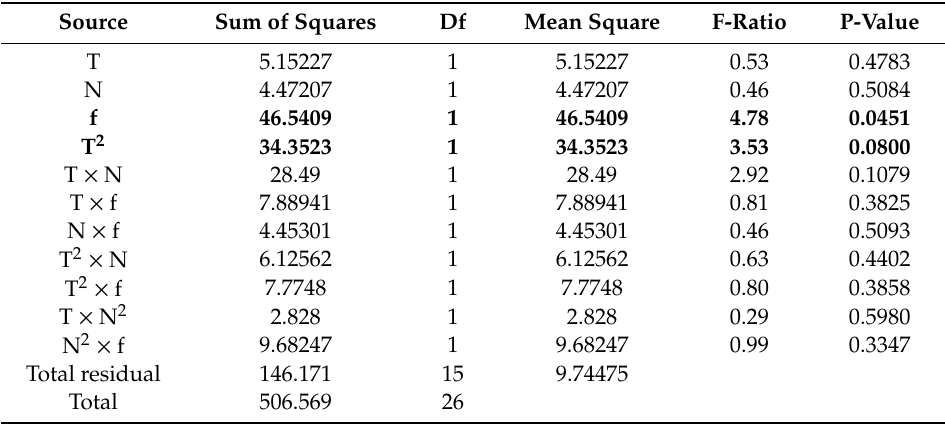
Table 4. Analysis of variance for E